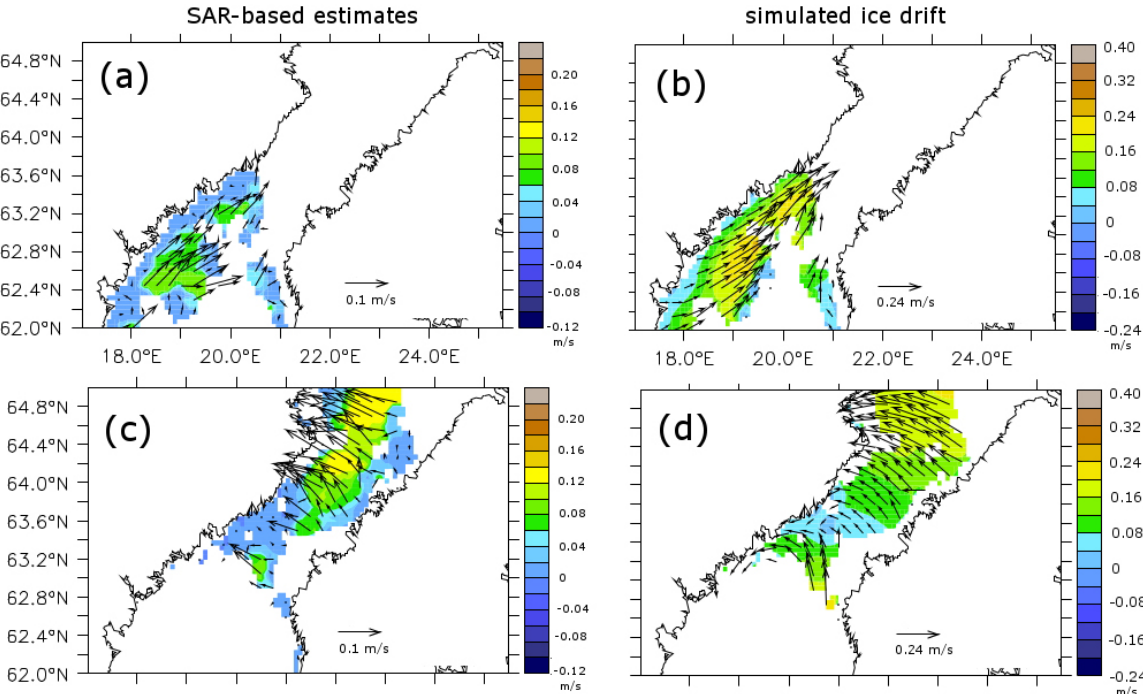
Figure 4. (a, c) Two exemplary SAR-based ice drift estimates compared to (b, d) the forecasted ice drift. The arrows depict ice drift, and the colors indicate the respective vector lengths. (a) refers to the SAR-based estimates of sea ice displacement during the time period between the 20 January, 20:17UTC, and the 21 January, 16:12UTC, interpolated on the model grid. (b) depicts an average of all 6-hourly forecast model outputs included in this period. Likewise, (c) refers to the SAR-based estimate during the time period between 1 February, 15:51UTC, and the 3 February, 05:03UTC. (d) refers to the corresponding average of 6-hourly model snapshots. Observe the different arrow lengths in (a) and (b) (resp., c and d ). (a) and (c) were generated by using MyOcean